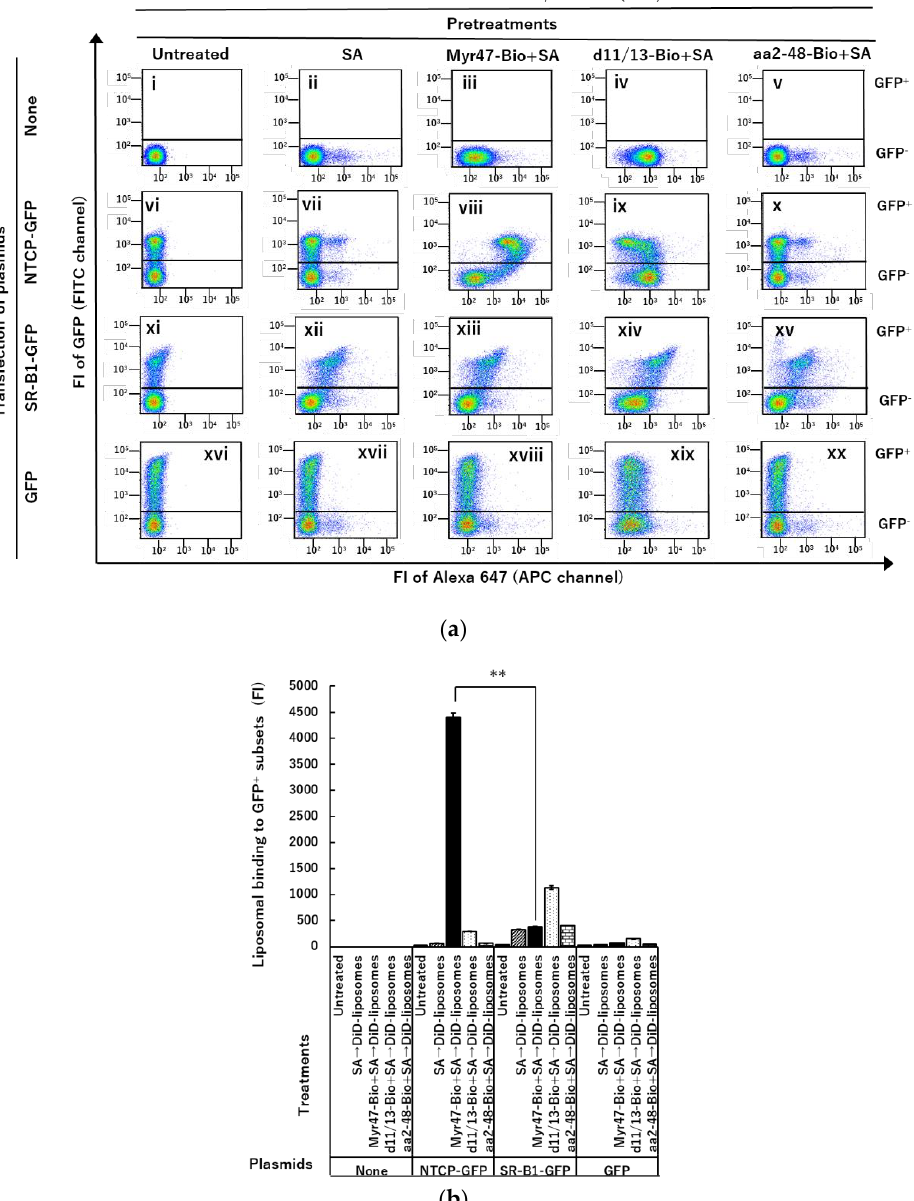
Figure 4. Flow cytometric analyses of liposomal binding to the surface of HEK293T cells transiently expressing NTCP-GFP via Myr47+SA. ( a ) Two-parameter dot plot analyses of liposomal binding to HEK293T cells expressing NTCP-GFP, SR-B1-GFP, or GFP. HEK293T cells transfected with or without plasmids indicated in the Figure were treated with SA, Myr47-Bio+SA (i.e., Myr47-Bio premixed with SA), d11/13-Bio+SA (i.e., d11/13-Bio premixed with SA), or aa2-48-Bio+SA (i.e., aa2-48-Bio premixed with SA) and then the binding of DiD-DOPC/PEG-Bio (10%) was examined. In panels (i~xx), upper and lower gates indicate GFP + and GFP - subsets, respectively. To obtain dot plot data, we analyzed 30,000 cells. ( b ) Binding of DiD- DOPC/PEG-Bio (10%) to GFP + subsets of HEK293T cells with or without expressing NTCP-GFP, SR-B1-GFP, or GFP. FI of DiD-DOPC/PEG-Bio (10%) bound to the cell surface of GFP + subsites was shown as a bar graph. Each data indicated in ( b ) corresponds to a GFP + subset of a panel in ( a ). Data, which were obtained from 10, 000 in each assay, were expressed as geometric mean values ± standard errors (vertical bars) in triplicate assays. Statical analysis was performed using Student’s t -test; ** p < 0.01.